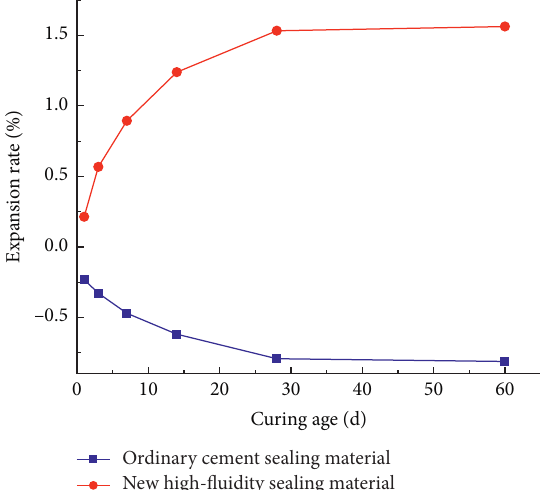
Figure 11: Change rule of expansion rate between new high-fluidity material and common cement material.